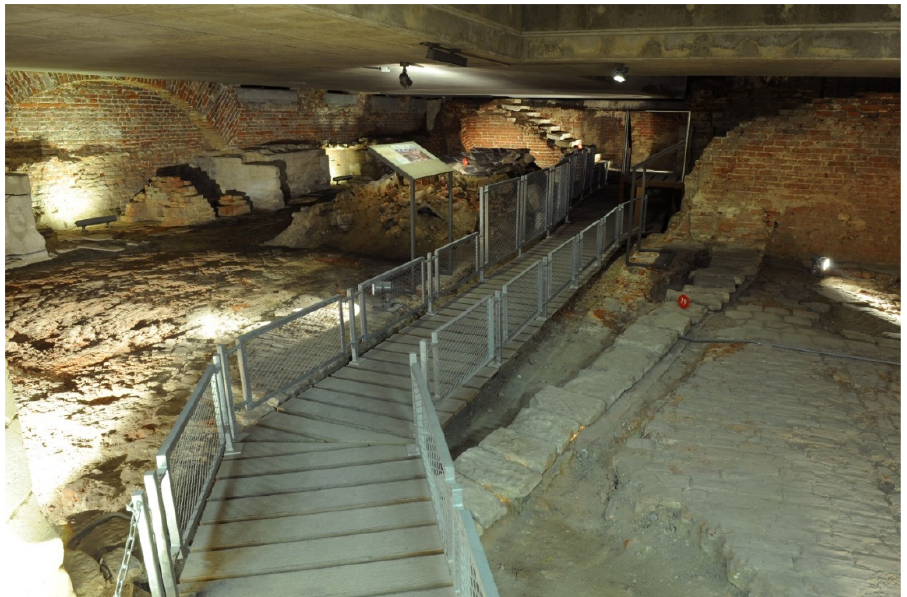
Figure 4. The actual ruins of the palace mentioned above, standing as an Underground Museum.